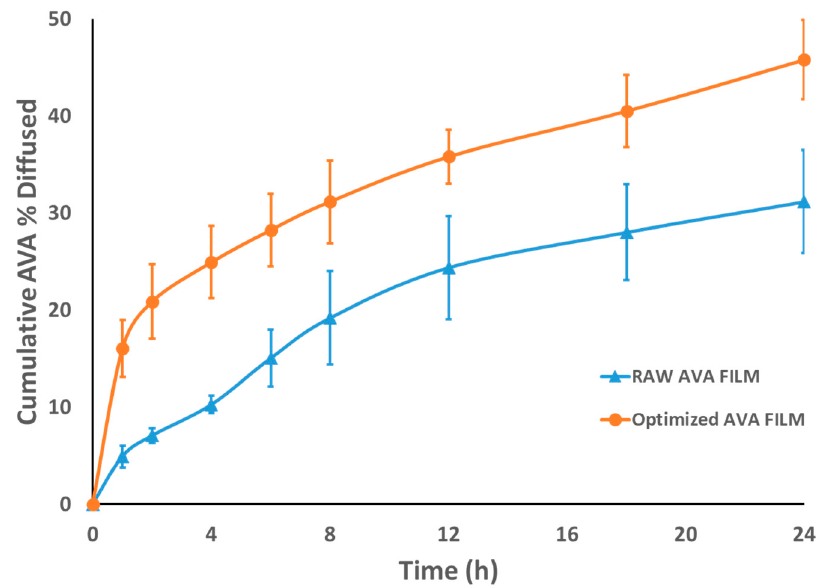
Figure 3. Ex vivo permeation profile of raw AVA-loaded film and optimized AVA-MM-loaded film. All data are expressed as the mean ± SD of three independent experiments. Table 4. Composition of the optimized AVA-MM-loaded transdermal film with the observed, fitted, and residual values. Factor